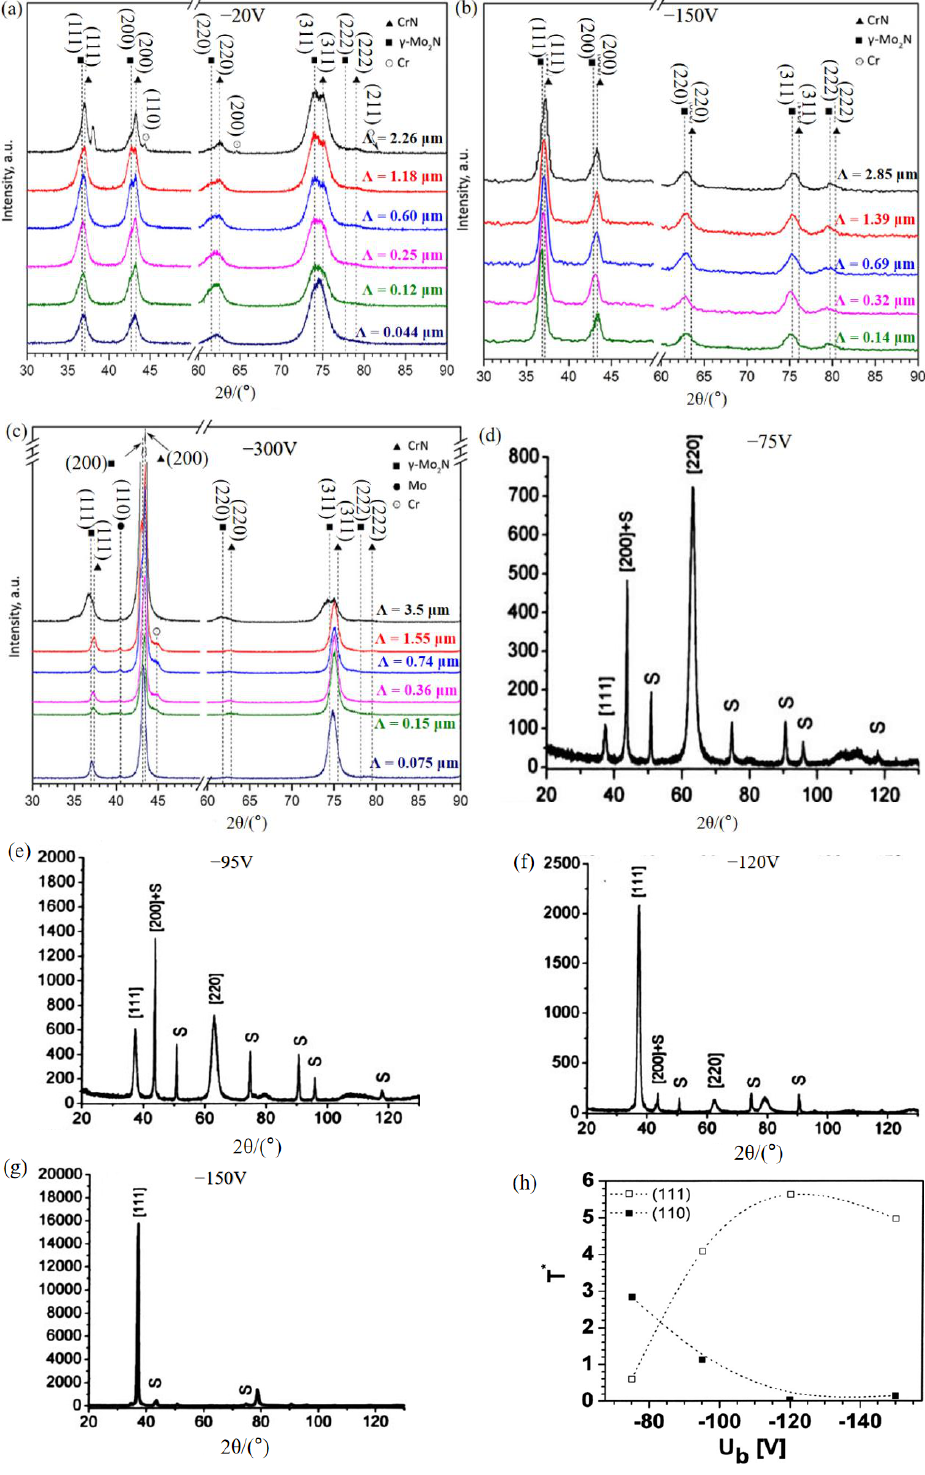
Figure 3. XRD patterns of ( a – c ) CrN/MoN [72] and ( d – h ) CrAlYN/CrN [20] multilayer films deposited at a series of biases, showing the change in film texture caused by changing the deposition bias. Reprinted with permission from [72] Elsevier 2018, [20] American Vacuum Society 2009.